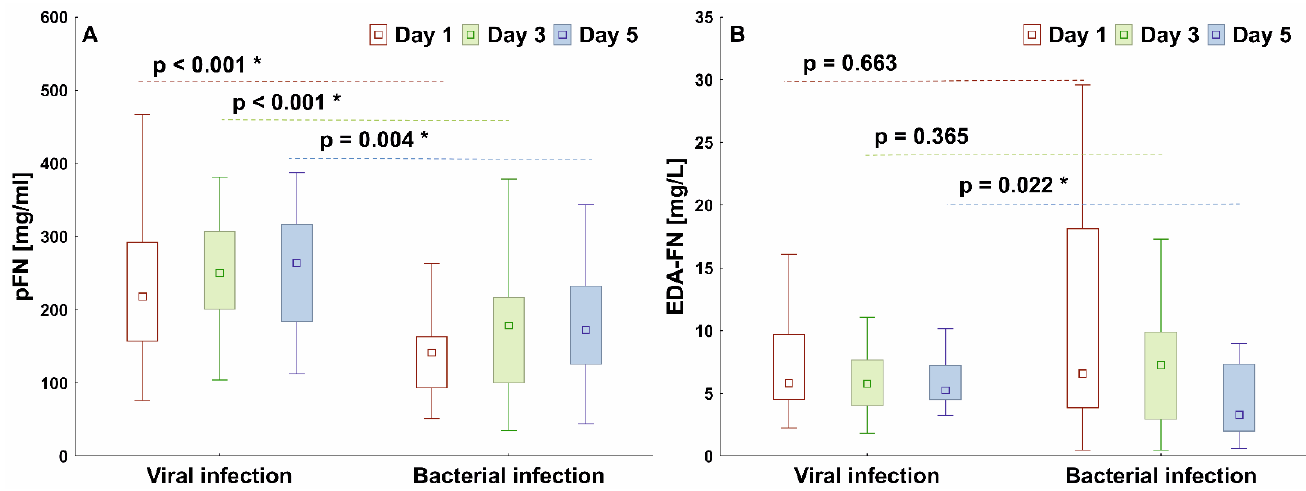
Figure 2 . Graphs comparing plasma pFN ( A ) and EDA-FN ( B ) concentrations of patients with a viral infection (COVID-19) or bacterial infection (sepsis). The box plots represent the median values (midpoint) with interquartile range between the 25th and 75th percentiles (box); the whiskers represent the minimum and maximum values. * indicates p -value less than 0.05.